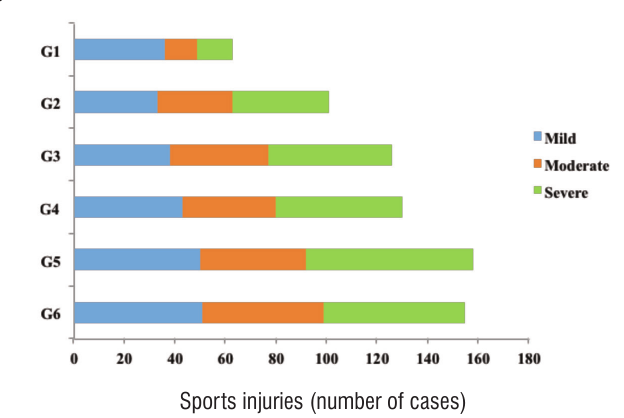
Figure 1 - Sports injury distribution according to severity and soccer player